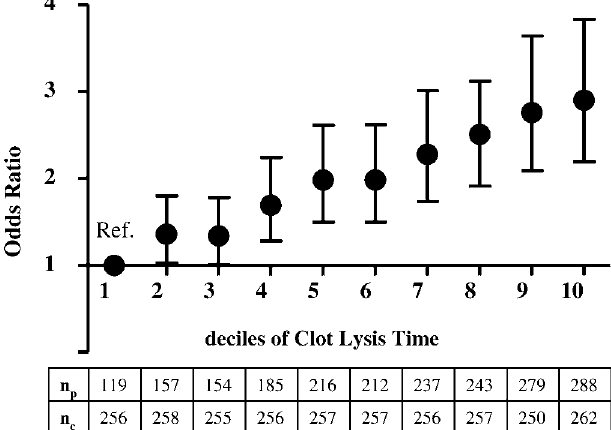
Figure 1. Risk of Venous Thrombosis for Deciles of Clot Lysis Time The odds ratios are adjusted for age and sex. Error bars, 95% CI; n c , number of control participants (all); n p , number of patients; Ref., reference category.